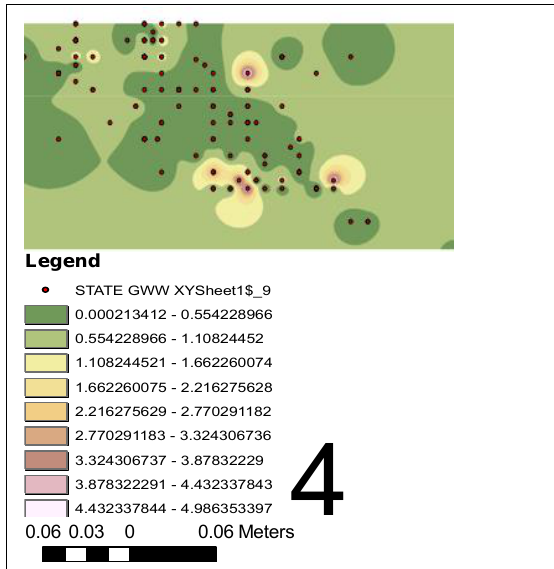
Fig (10) Flouride Distribution mg/l (F) flouride found in a rock formation, which is natural occurant , flouride in ground water has a health effect to human being